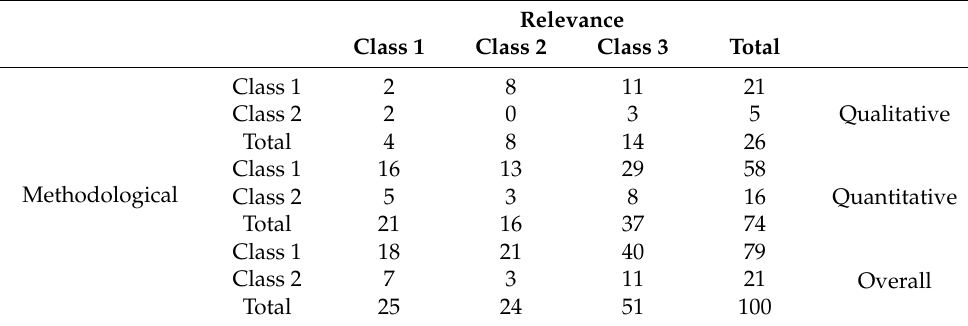
Table 1. Contingent table (methodological quality vs relevance